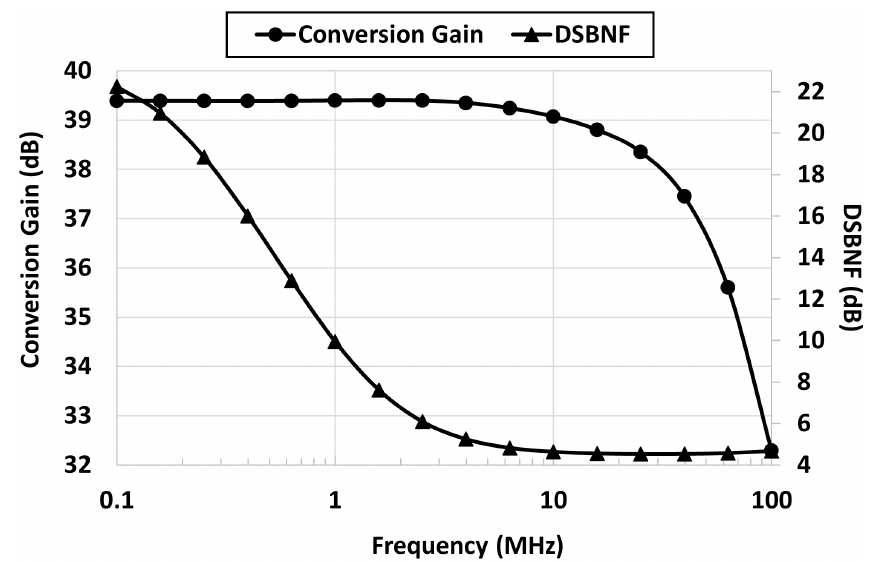
Figure 14. The post-layout simulated NF versus the